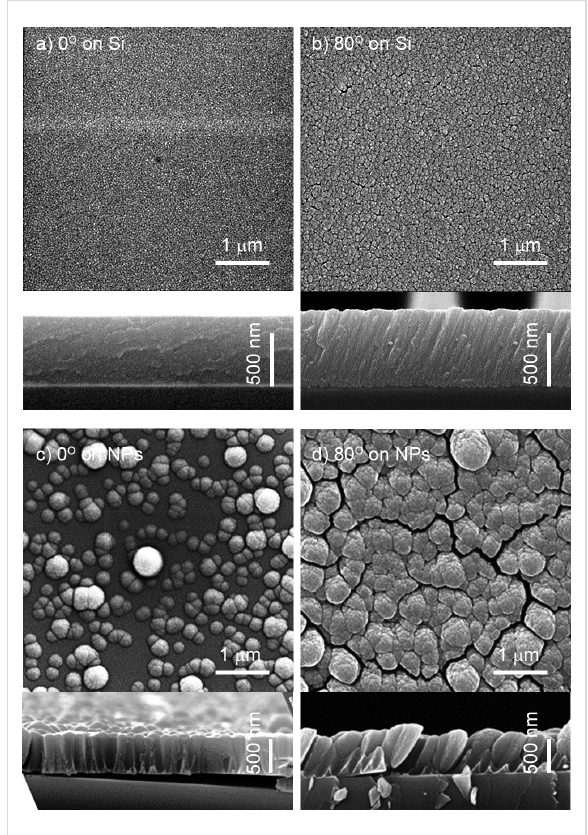
Figure 16: SEM images with combined top view and cross-sections of the deposits produced as a result of RF magnetron sputtering of nylon: a) normal deposition on blank Si substrate; b) GLAD at 80° on blank Si substrate; c) normal deposition over preseeded nylon-sputtered NPs; d) GLAD at 80° over preseeded nylon-sputtered NPs (reprinted from [81], with permission from